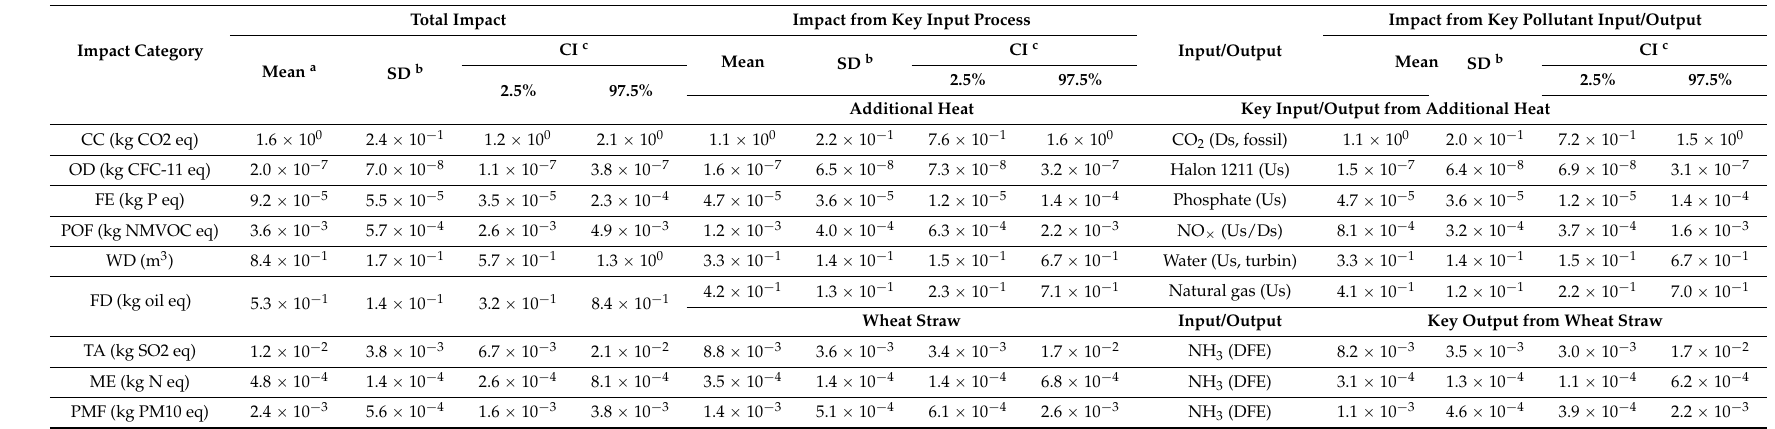
Table 5. Results from the Monte Carlo Uncertainty analysis related to 1 kg of the bio-based BDO production, for key input processes and linked pollutant emissions. Ds: downstream; Us: upstream; DFE: direct field